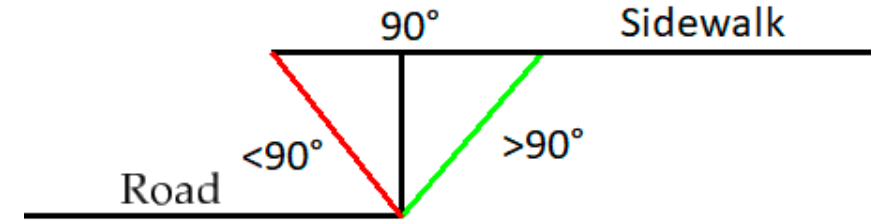
Figure 8. Profile view of the road curb vertical variation schema. Red line represents the infra- excavation curb situation.